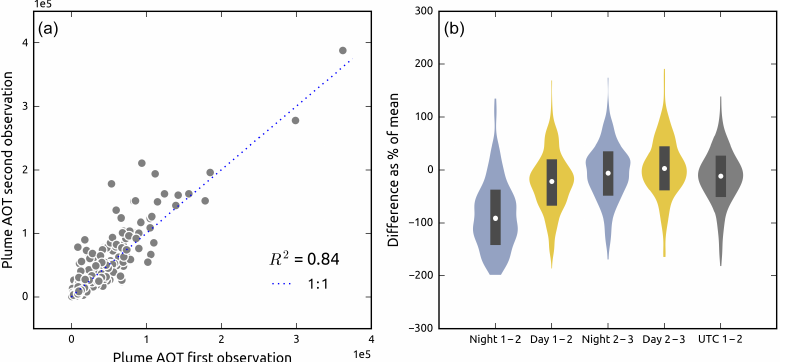
Figure 4. Fire-emitted AOT for 284 cases with two estimates for the same diurnal emission period starting and ending at 00:00 UTC, obtained at different stages of plume development (a) . Plot (b) shows differences between two fire-emitted AOT estimates expressed as a percentage of their mean value for the three night-time and daytime emission periods and two UTC periods shown in (a) .